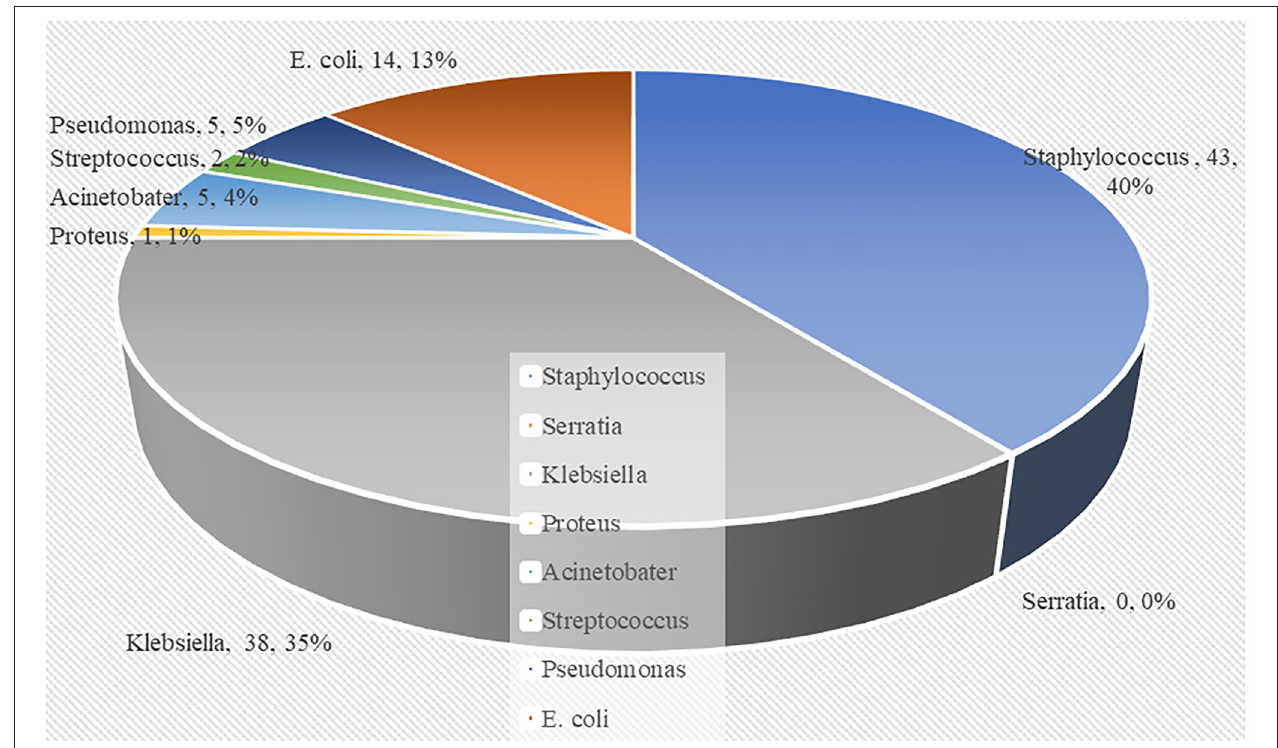
FIGURE 1 | Pie chart showing the distribution of deceased neonates according to the causative